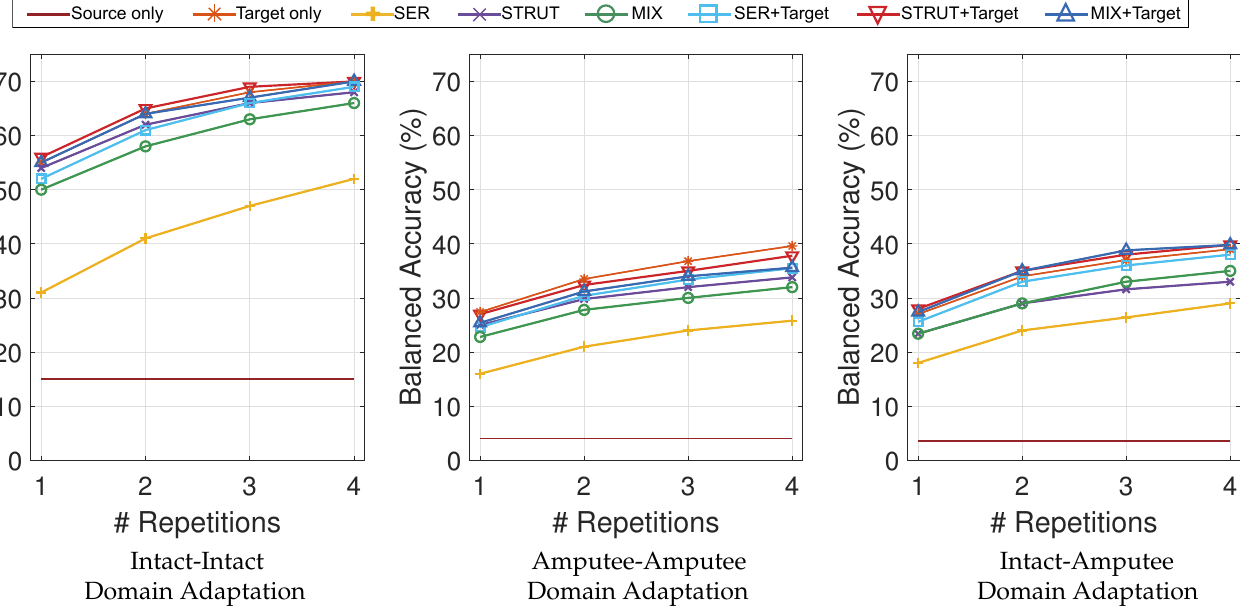
Figure 4. DB2 and DB3 Results: inter-subject balanced classification accuracy as a function of number of training repeti- tions on